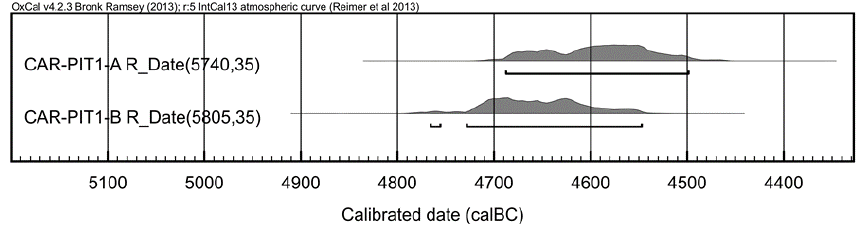
Figure 5. Report on C-14 dating of olive from structures A and B in Hishuley Carmel site, in the Pozna ń Radiocarbon Laboratory, Poland